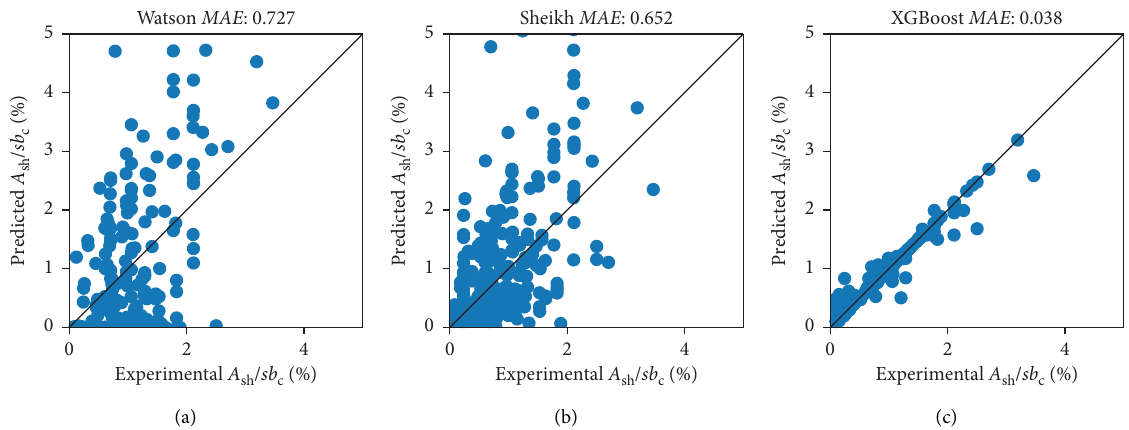
Figure 8: Two-way PDPs of transverse reinforcement ratio. (a) Normal-strength and high-strength concrete. (b) Normal-strength